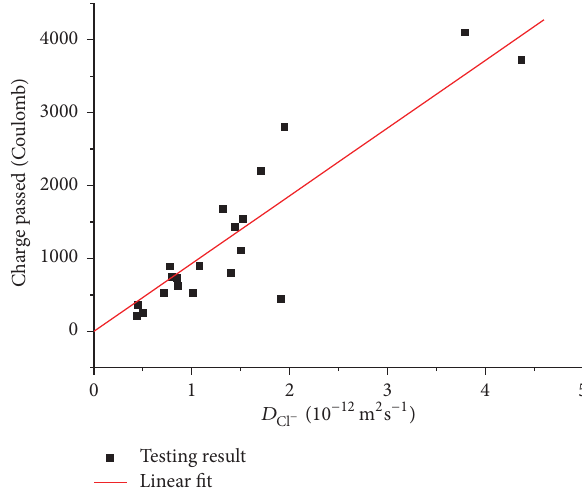
Figure 13: Relationship between chloride ion diffusion coefficient using ACIS and 6 h electric flux from ASTM C1202